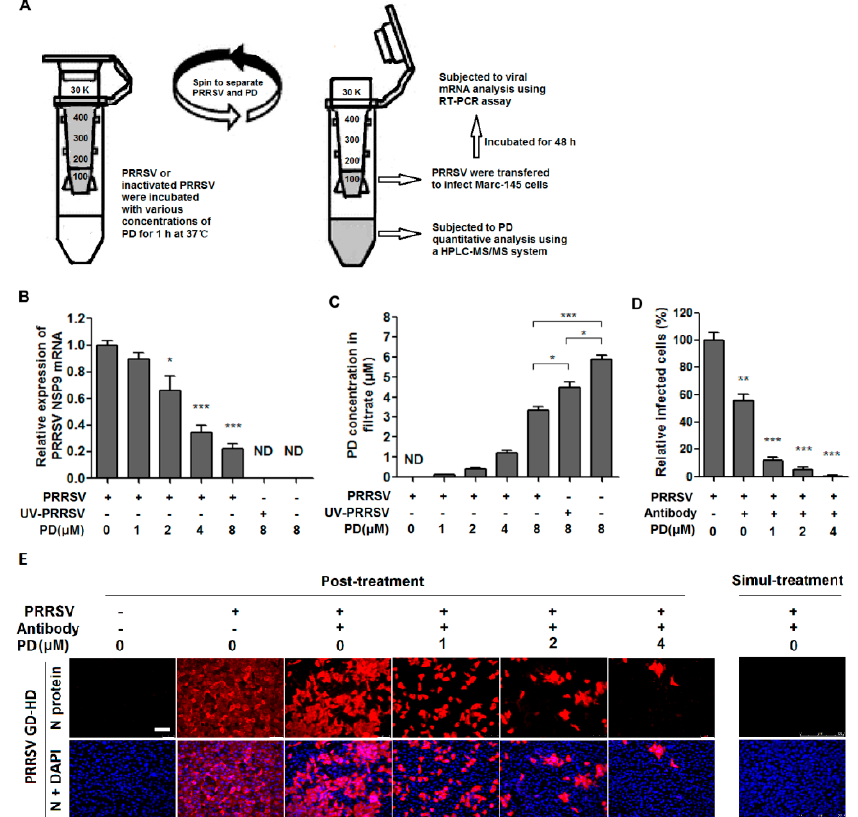
Figure 5. PD interacts with PRRSV directly and inhibits its cell-to-cell spreading. ( A – C ) Direct interaction assay of PD and PRRSV. 100 μ L of PRRSV GD-HD (2×10 6 PFU) or equal UV-inactivated (120 μ W/cm 2 , 30 min) PRRSV GD-HD was mixed with various concentrations of PD in essential medium (0.9 mL total volume) for 1 h at 37°C. Then PRRSV and PD were separated by ultrafiltration, as shown in ( A ). Recovered PRRSV were resuspended to infect MARC-145 cells. The PD in filtrates was quantified using a HPLC-MS/MS system as described in the methods. The results of relative expression of PRRSV NSP9 mRNA are shown in ( B ), and the results of PD concentration in the filtrates are shown in ( C ). Statistical significances in B and C are denoted by * p < 0.05, ** p < 0.01, and *** p < 0.001. ( D , E ) MARC-145 cells grown in 6-well plates were infected with PRRSV (0.05 MOI) at 37°C for 3 h in the absence of neutralizing serum (post-treatment) to permit viral internalization, or in the presence of neutralizing serum (1:200 dilution, simul-treatment) to neutralize free virions and prevent infection (for post-treatment, neutralizing serum was added at 3 hpi; for simul-treatment, neutralizing antibody added to the culture simultaneously with virus addition). After removing free virus particles, infected cells were cultured for further 48 h in medium containing PD at various concentrations and neutralizing serum (1:200 dilution). IFA for the N protein was performed at 48 hpi as described in the legend to Figure 1 and the methods. Scale bar: 100 μ m. Results shown in D are the mean values of percentages of PRRSV-infected cell ratio in PD-treated groups compared to the DMSO-treated control (0 μ M PD, set as 100%) from three independent IFA experiments, and E is one representative IFA data from E .